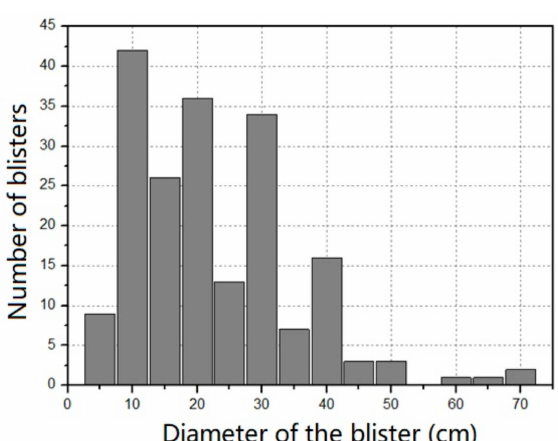
Figure 3. Blister size distribution.